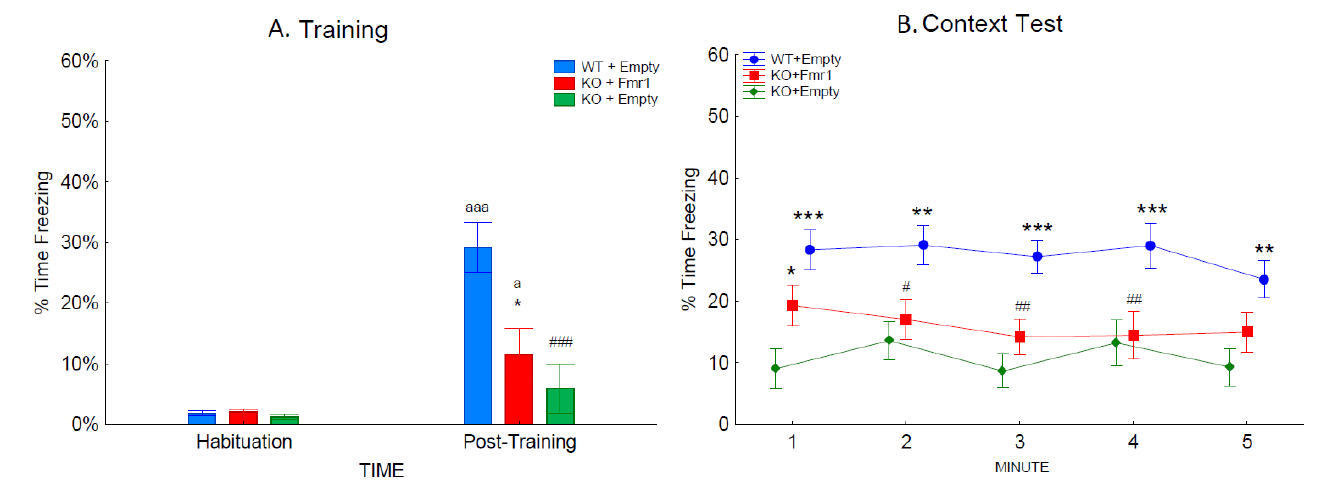
Figure 7. Contextual fear conditioning. The effects of the treatments on associative learning during training and contextual fear conditioning. ( A ) The percentage of time the mice of the three groups froze during habituation and the post-training period during training. ( B ) The percentage of time the mice of the three groups froze during re-exposure to the training context. Differences from the WT + Empty group are shown by # = p < 0.05, ## = p < 0.1, and ### = p < 0.001. Differences from the KO + Empty group are shown by * = p < 0.05, ** = p < 0.01, and *** = p < 0.001. Differences from habituation are shown by a = p < 0.05, aa = p < 0.01, and aaa = p < 0.001.